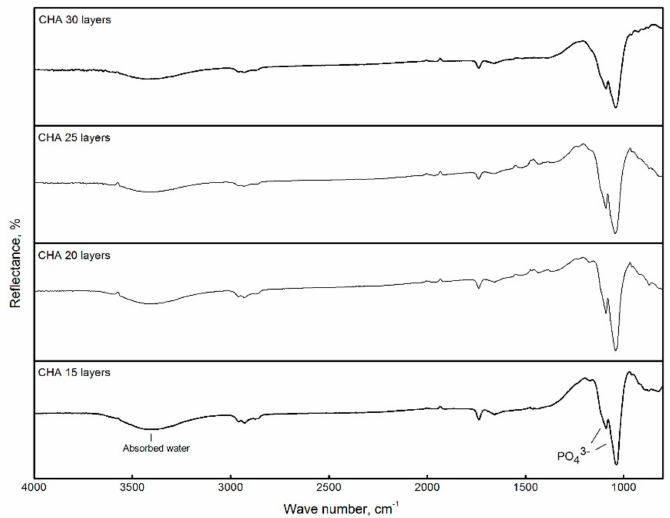
Figure 4. FTIR spectra of sol-gel derived films with 15, 20, 25, 30 layers of CHA.